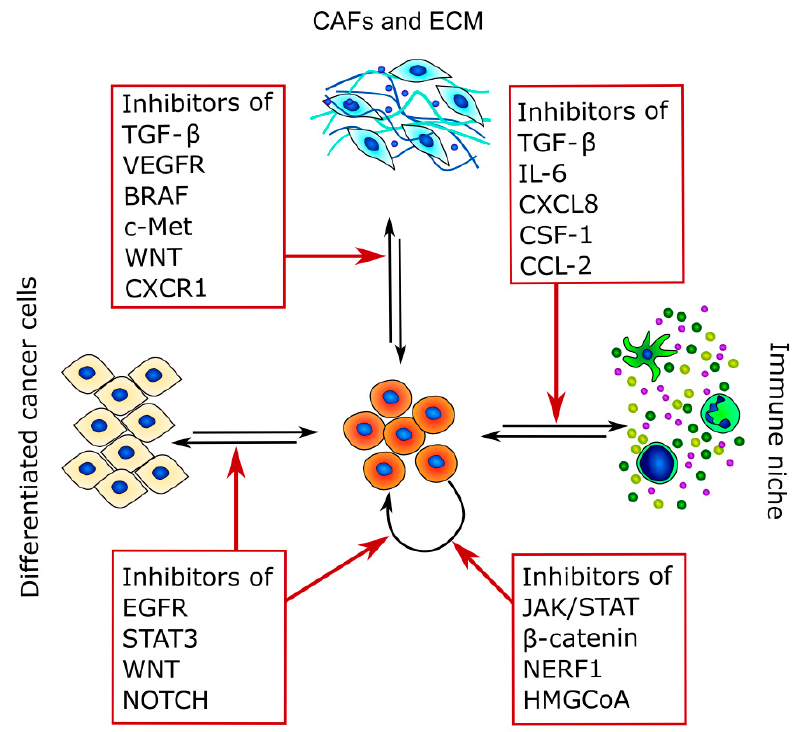
Figure 3. Therapeutic targets of CSCs and TME crosstalk. The figure summarizes the main pathways that can be targeted and highlights the main interactors of CSC crosstalk in which they are involved. Table 3. Compounds that act against CSC ‐ related pathways.